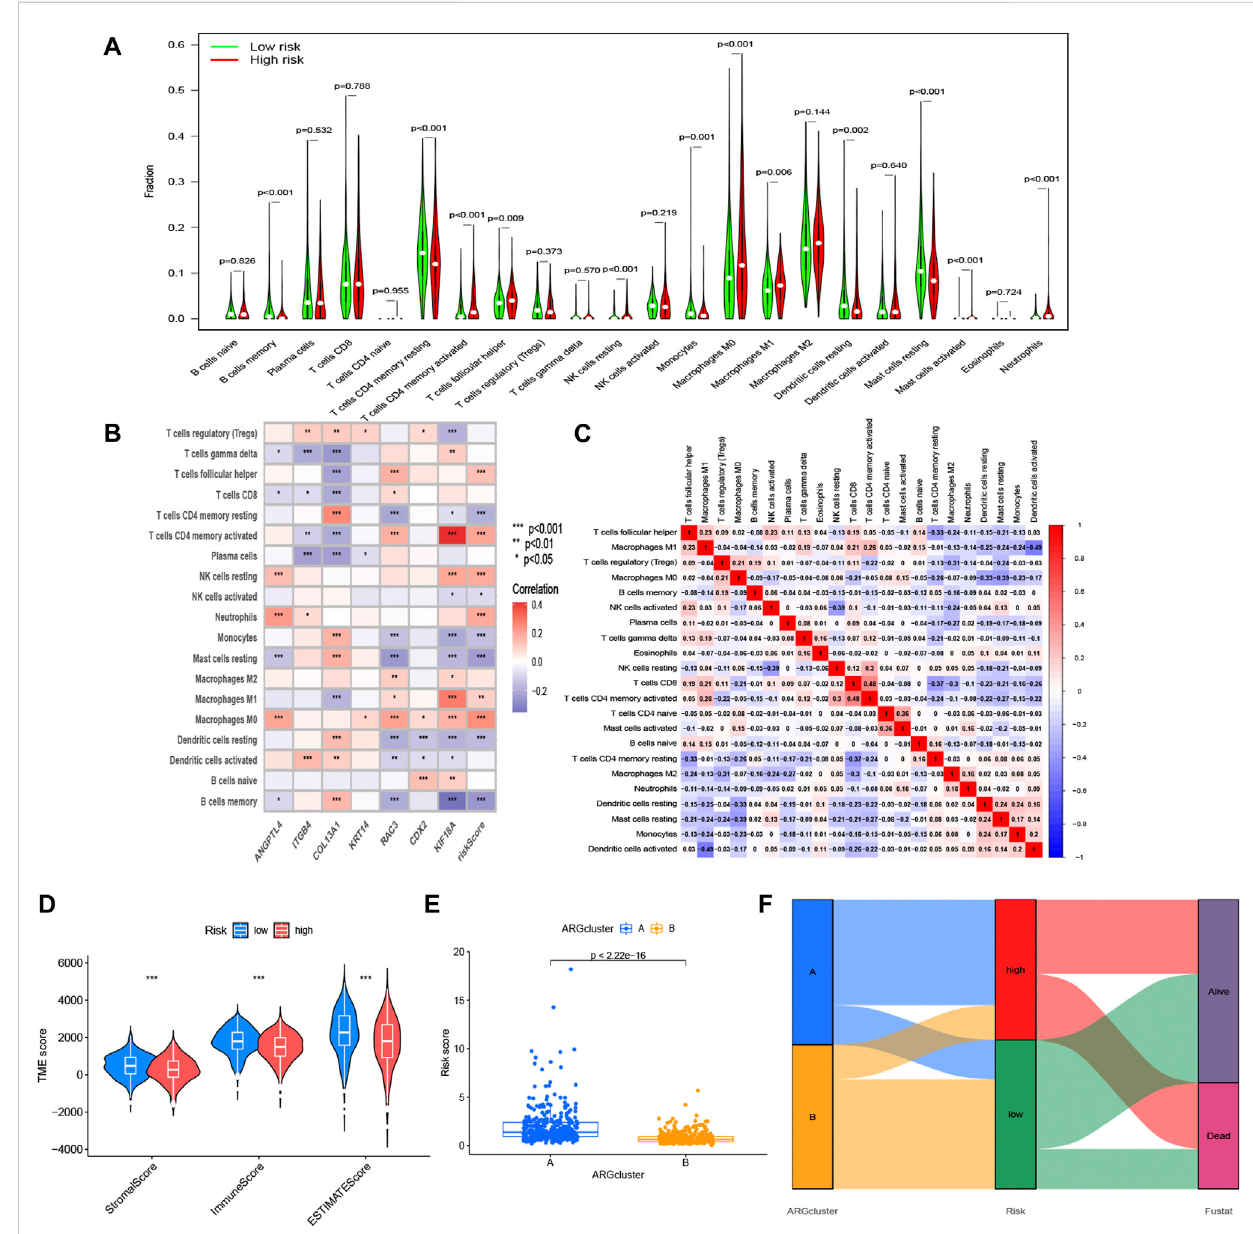
FIGURE 7 Immune-related analysis based on the risk model. (A) Expression differences of immune cell in fi ltration in risk subgroups. (B) Correlation between 7ARGs,riskscores,andtheimmunecells. (C) Correlationbetweentheseimmunecells. (D) Othercharacteristicsincludingestimatescore,immunescore, and stromal score between the high- and low-risk groups. (E) Differential risk score comparison in the two ARGs patterns. (F) Sankey diagram of the relationship between two ARGs patterns, survival status, and risk scores. * p < 0.05, ** p < 0.01 and *** p <